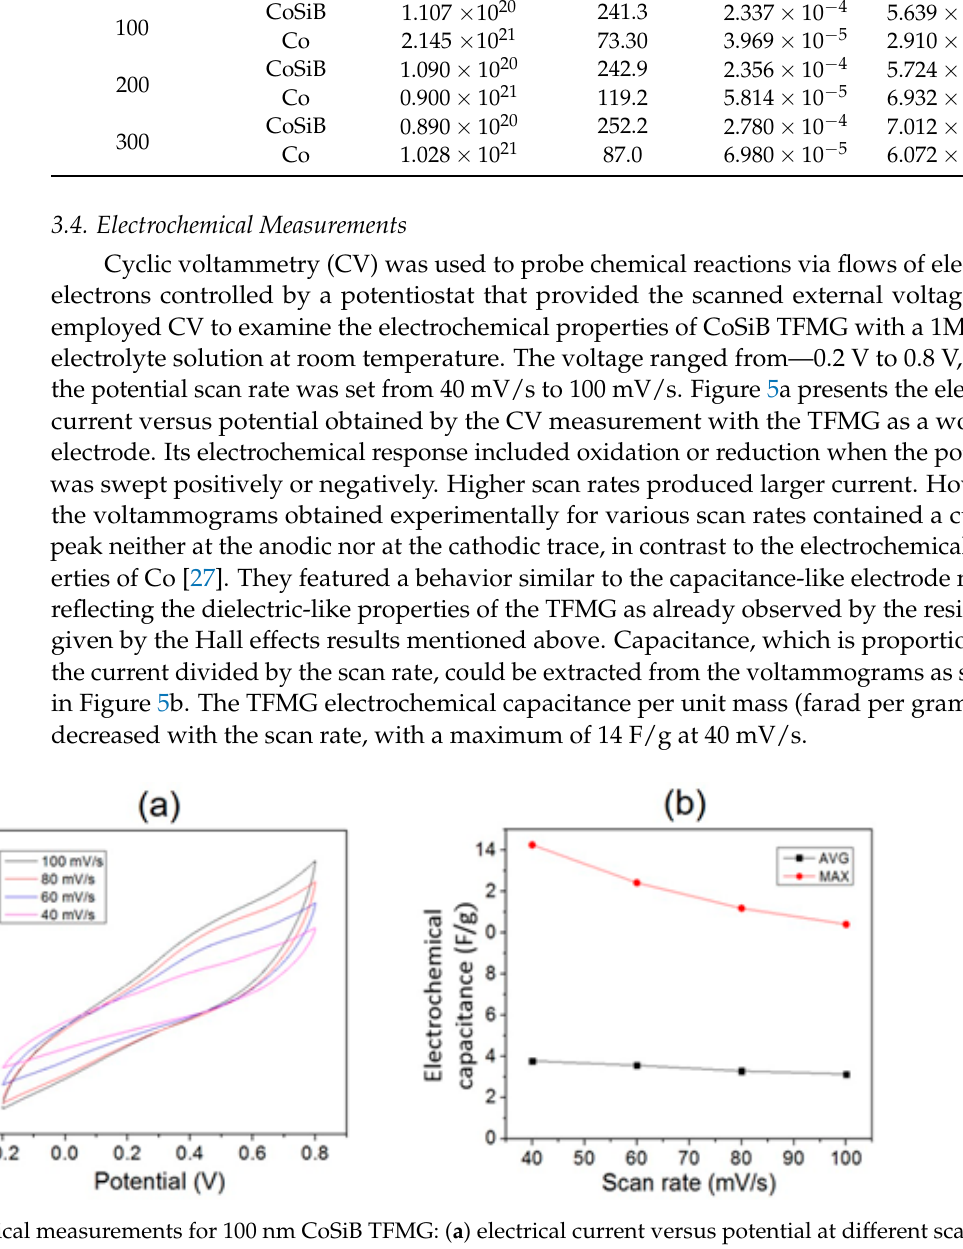
Table 1. The results of room temperature Hall measurements with the CoSiB TFMG and pure Co thin film.